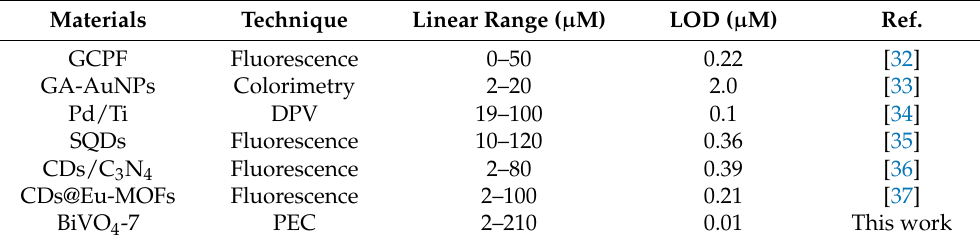
Figure 5. ( a ) Photocurrent response curve and ( b ) corresponding calibration curve for detection of different concentrations of Cr (VI) (2 to 210 µ M) using BiVO 4 -7. Table 1. Comparison between the performance of the proposed PEC sensor and reported results for Cr(VI) detection.